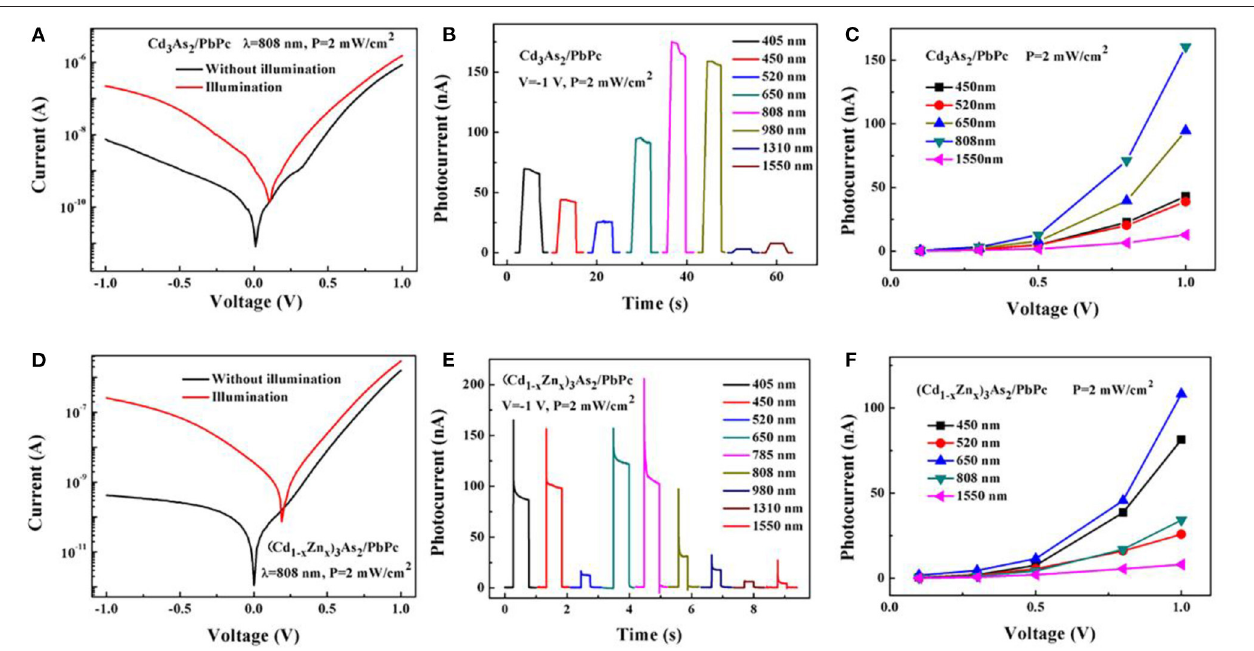
Zn x ) 3 As 2 /PbPc − x 1V with laser power intensity of 2 mW/cm 2 . −